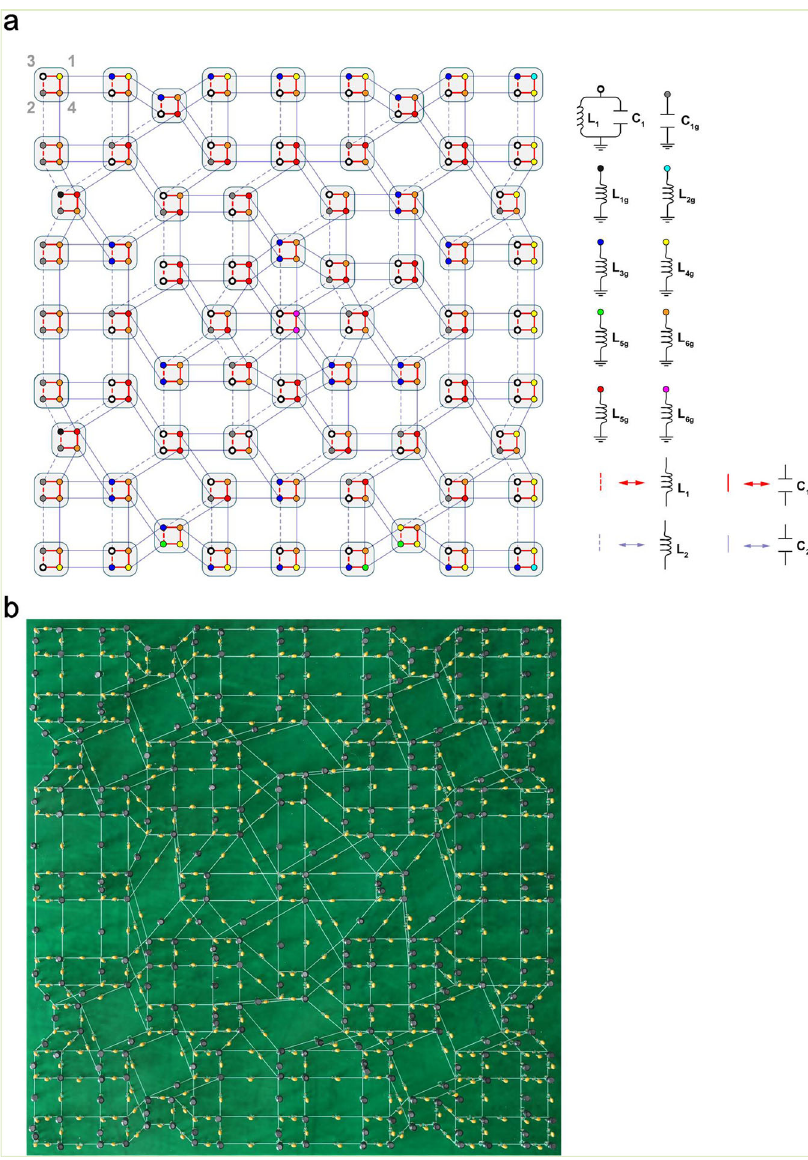
Fig. 1 Quasicrystalline quadrupole topological insulators in electrical circuits. a Schematic of the circuit with 69 unit cells. One unit cell consists of four sites labeled as 1, 2, 3, and 4 at the left-up corner. The colored sites are wired to grounded inductors and/or capacitors listed on the right. For example, the black hollow point 3 is connected to the ground by the capacitor – inductor pairs C 1 and L 1 , and the yellow point 1 is connected to the ground by L 4g. The sites in the same unit cell are wired by intracell inductors L 1 (red dashed lines) and capacitors C 1 (red solid lines), and the intercell elements between the unit cells are inductors L 2 (gray dashed lines) and capacitors C 2 (gray solid lines). b Photo of the fabricated circuit. The yellow and black elements are capacitors and inductors, respectively, and the wirings are indicated on overlay of the printed circuit